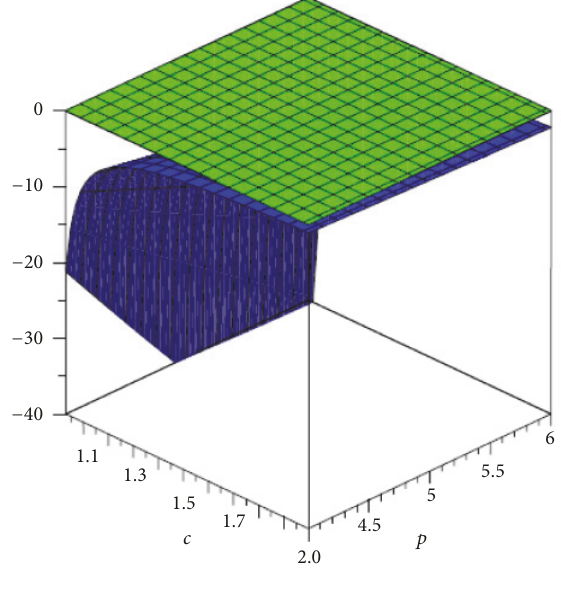
Figure 2: The 3D image of 𝑑 󸀠󸀠 (𝑐) when 𝛼 = 1 , 𝛽 = 1 , 𝛾 = 1 , 𝑝 > 4 .